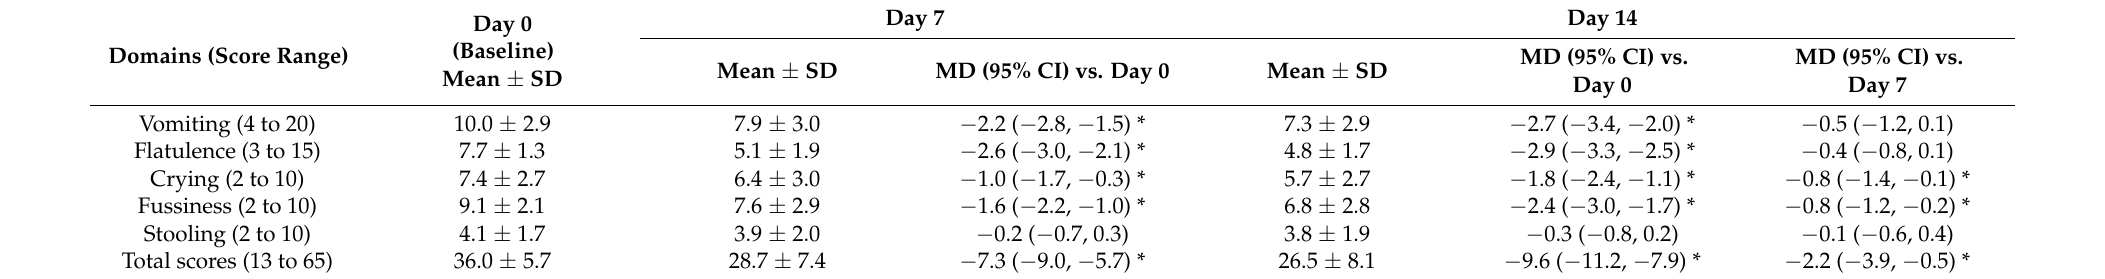
Table 2. IGSQ scores at Day 0 (baseline), Day 7, and Day 14 of feeding intervention.